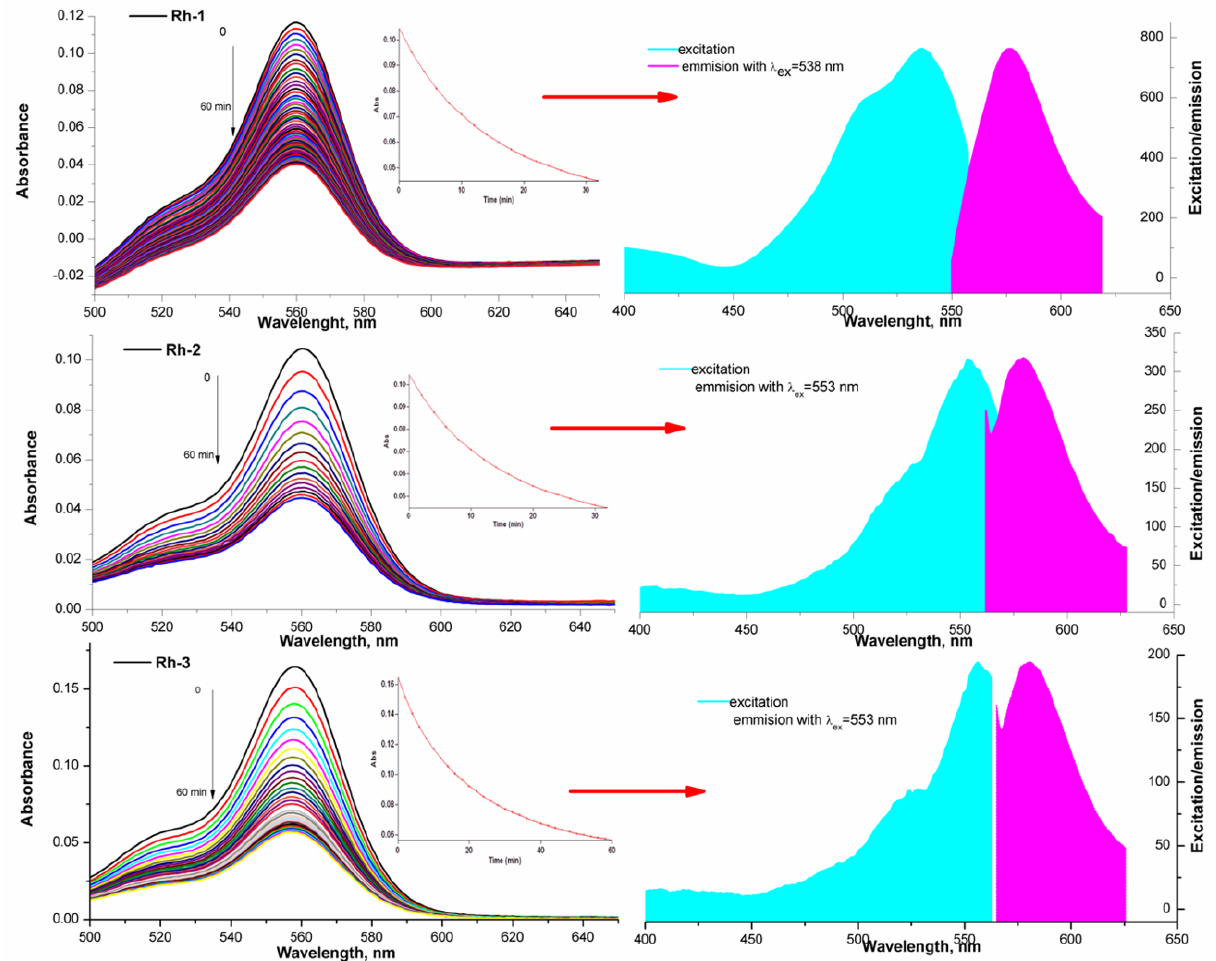
Figure 6. Uv-Vis kinetic plot of the first-order reaction between ring-opened and formed of the spirolactam form at equal concentration of Rh-1, Rh-2, and Rh-3 (at 25 °C) and corresponding fluorescence spectra in aprotic solvent (triethylamine). Rh-1 λ abs (nm): 565, λ em (nm): 589, Stokes shift (cm − 1 ): 721; Rh-2 λ abs (nm): 561, λ em (nm): 593, Stokes shift (cm − 1 ): 962; Rh-3 λ abs (nm): 559, λ em (nm): 592, Stokes shift (cm − 1 ): 997.